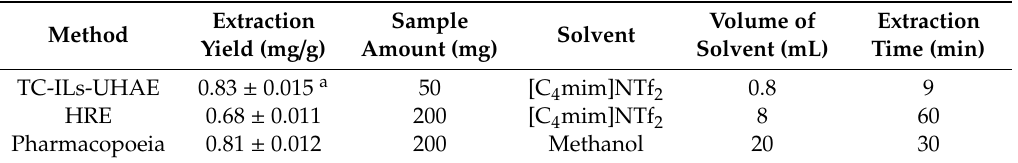
Table 1. Comparison of Temperature-Controlled Hydrophobic Ionic Liquids-Based Ultrasound / Heating-Assisted Extraction (TC-ILs-UHAE), Heated Reflux Extraction (HRE) and Pharmacopoeia Method.